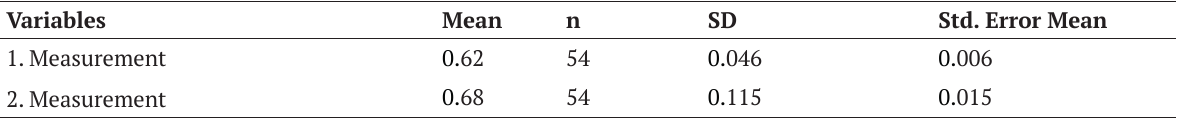
Table 6. Descriptive statistics of measurement values of the control group (Paired Samples Statistics) Variables